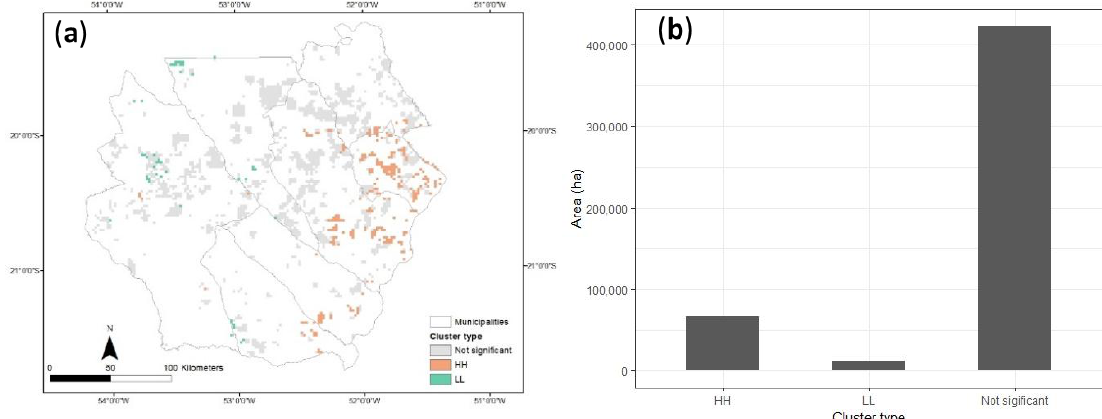
Figure 8. Consistency analysis of cluster’s mapped areas over time (2010–2016).